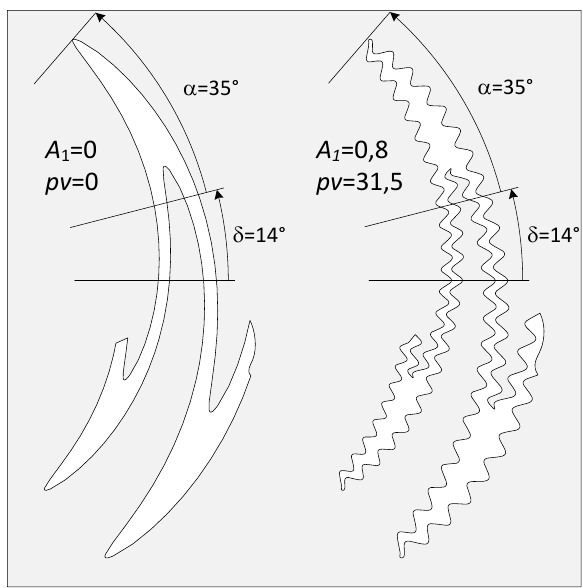
Figure 3. The cells and parameters of the antenna with and without a ripple.